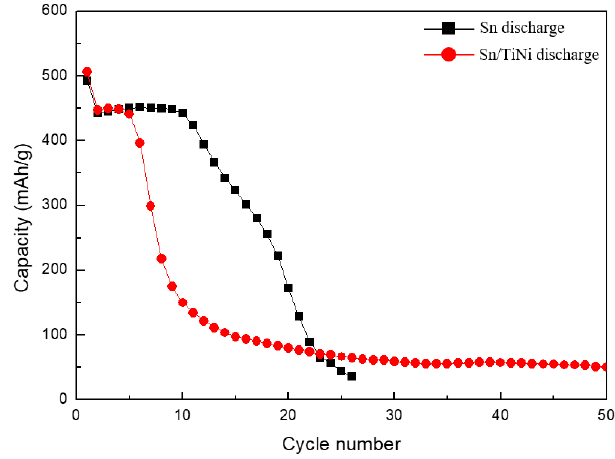
( b ) Figure 6. Discharge–charge curve of the ( a ) Sn and ( b ) Sn/TiNi electrode at 0.5 C in the voltage window of 0.01~1.2 V (vs. Li + /Li). Figure 7 shows the cycle performance of the Sn and Sn/TiNi electrodes. The capacity of the Sn electrode was constant up to 10 cycles, but rapidly degraded thereafter. Until the 19 th cycle, 50% capacity was maintained. The rapid degradation of capacity was the result